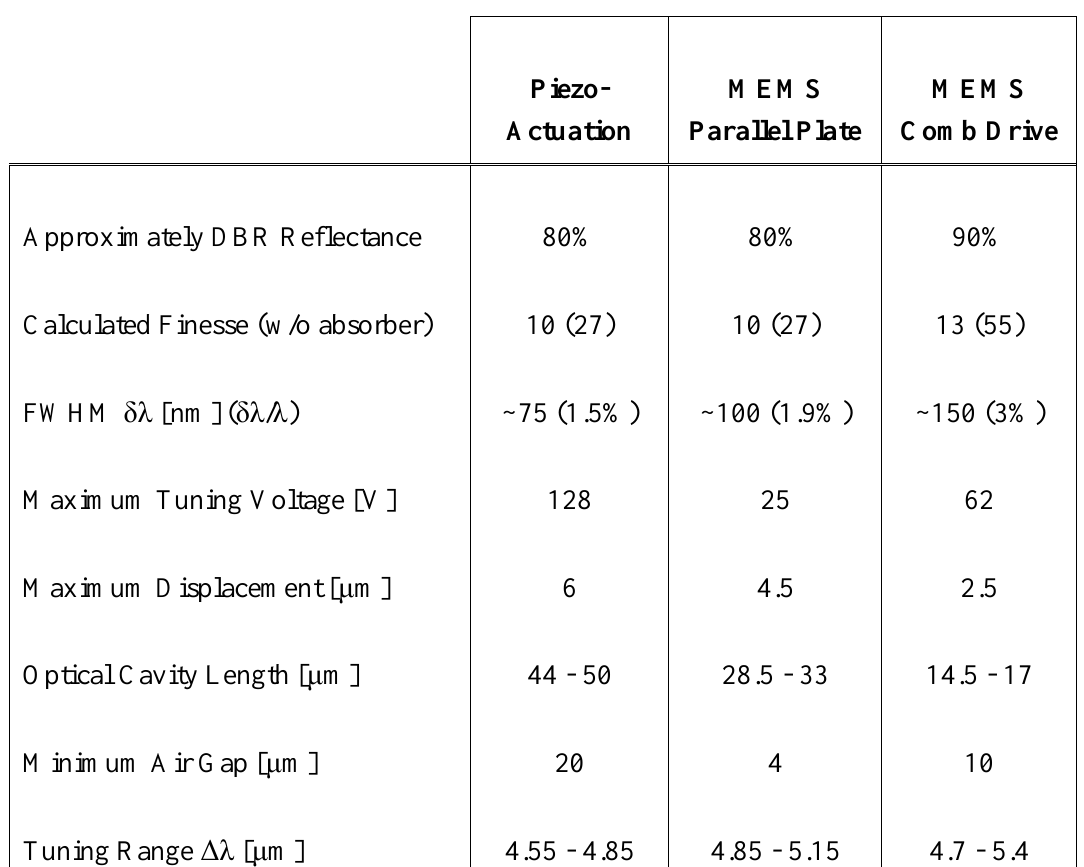
Table 1 : Characteristic data for detectors using piezo-actuation or MEMS electrostatic actuation in a parallel plate or comb drive configuration as tuning actuation